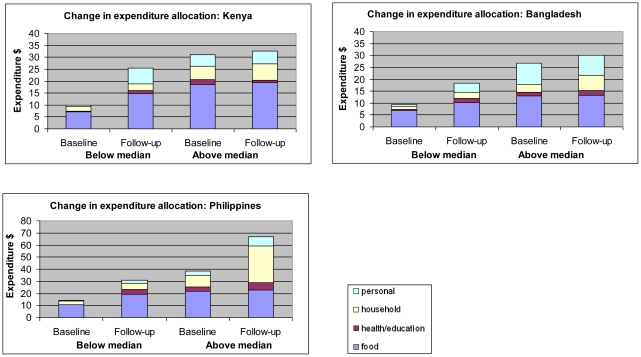
Change in allocation of expenses between baseline and follow-up among operated cases.